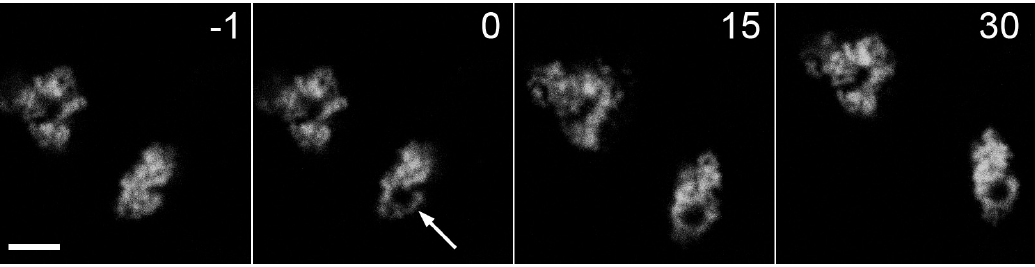
Figure 10. FRAP analysis of Trio-AG4 aggregates in HeLa Kyoto cells. Fluorescence was bleached by 488 nm laser at the point designated by arrow. Numbers indicate time in minutes. Scale bar, − 5 µm.